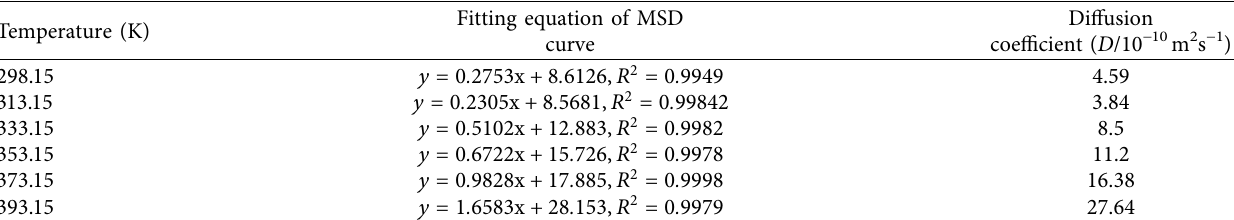
Table 6: Fitting results of difusion coefcients of SiO